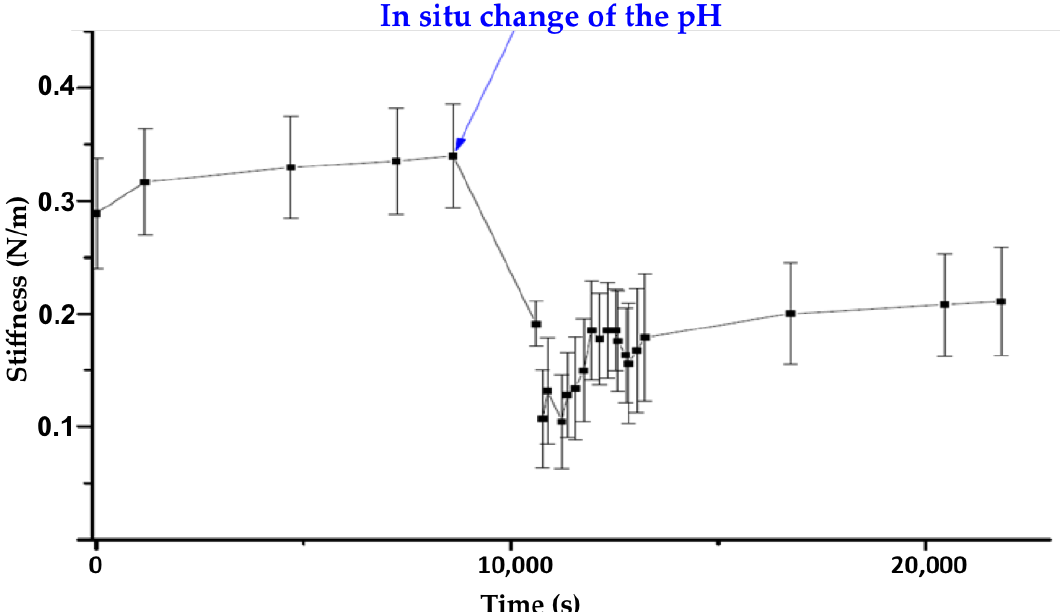
Figure 9. Stiffness profile of the evolution of the measured stiffness of a microMOF (+) particle following the addition of KOH.